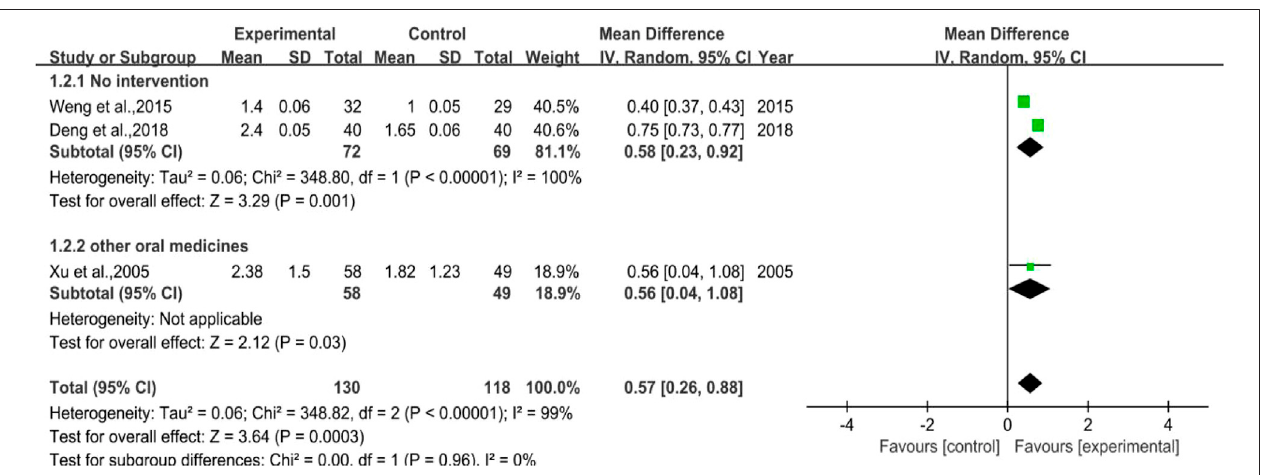
Frontiers in Pharmacology |